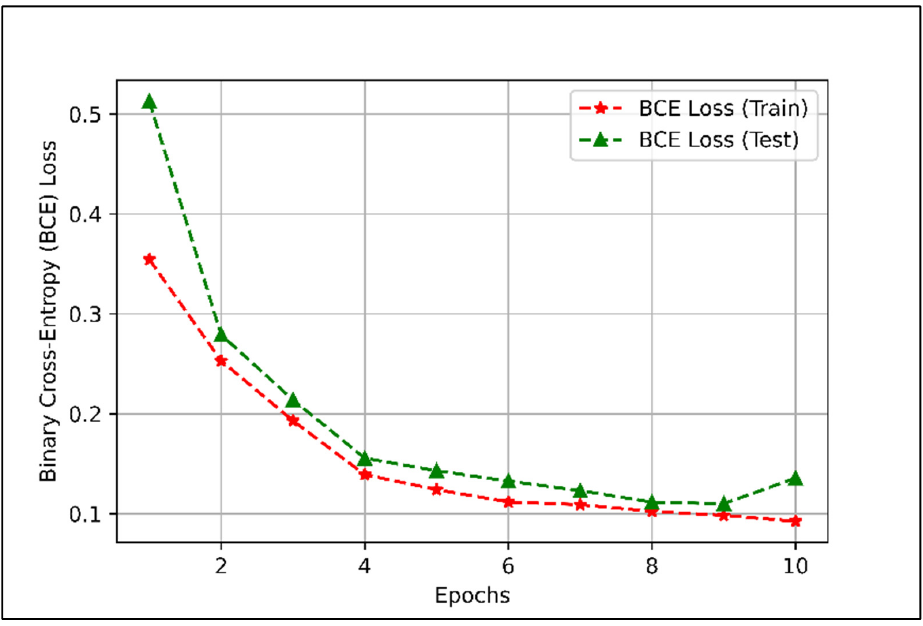
Figure 7. DLDC model training as well as testing binary cross entropy loss for 10 training epochs.